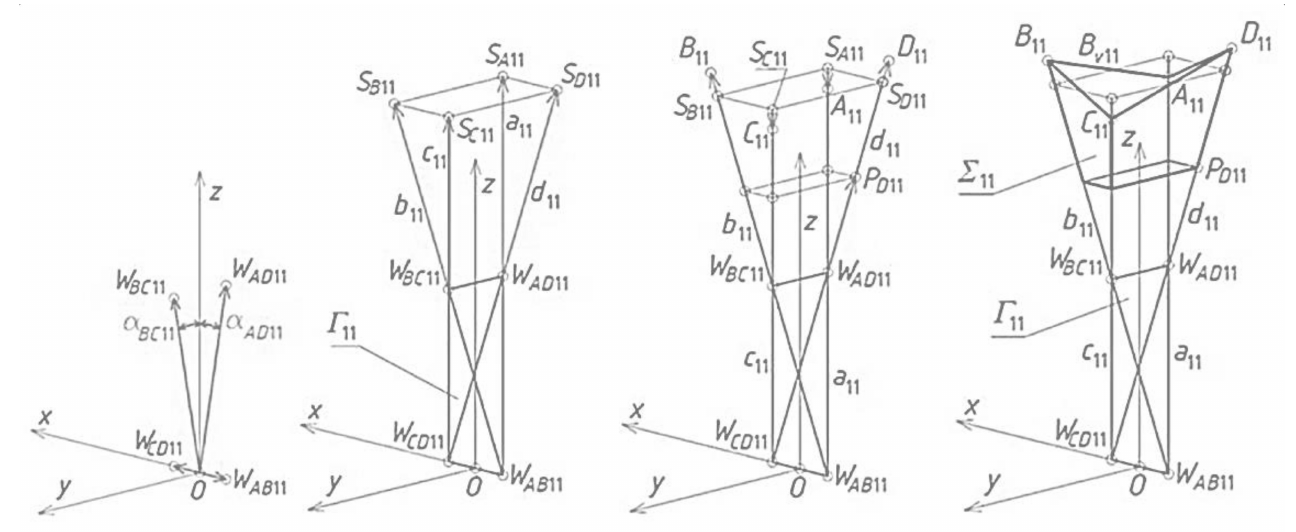
Figure 7. Stiff motions: translations and rotations for creating meshes Γ 11 , B v 11 and ∑ 11